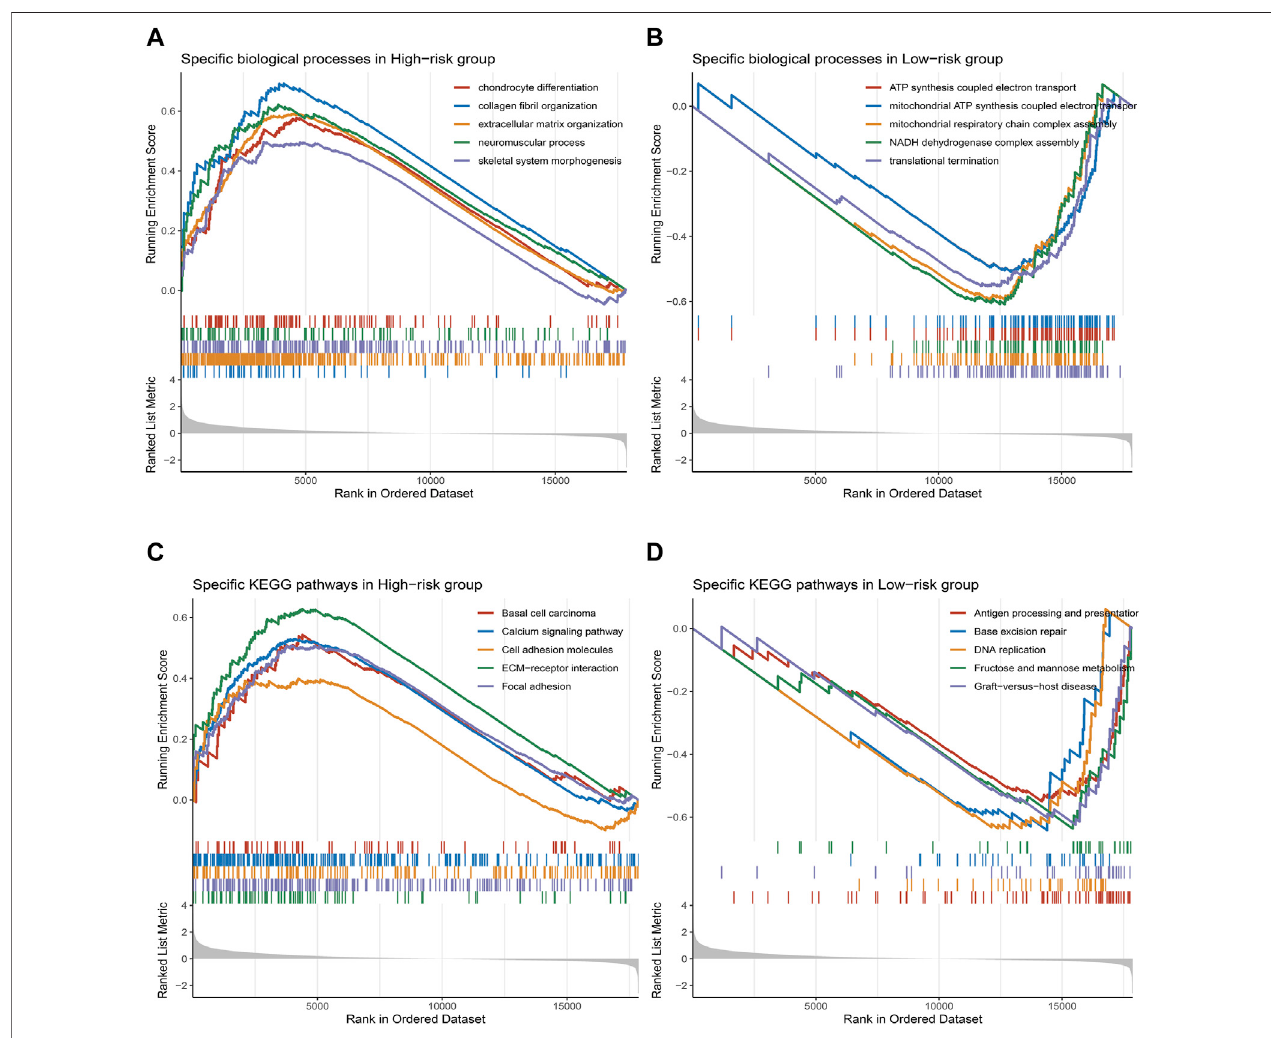
FIGURE 5 | GSEA and prediction of chemotherapy response. (A – D) . The top fi ve GO terms (A,B) and KEGG pathways (C,D) in the two subtypes.